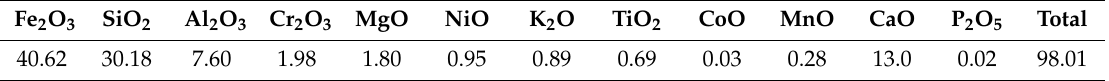
Table 1. Chemical composition (wt %) of